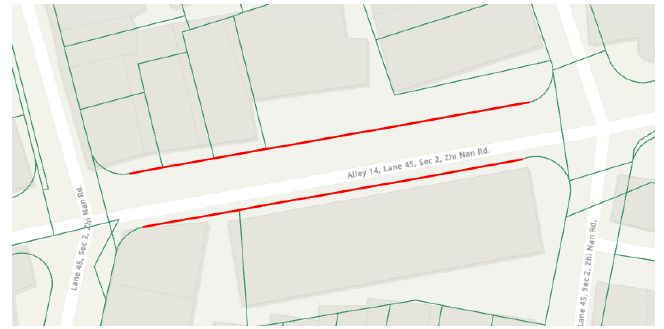
Figure 18. Possible cadastral detail line on an existing road boundary.